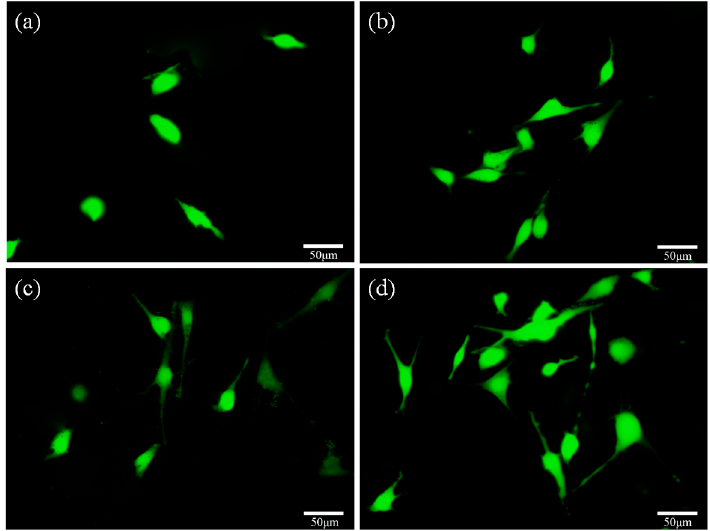
Figure 11. Fluorescence microscopies of MG63 cells cultured on scaffolds without CaSiO 3 ( a , b ) and scaffolds with 20 wt % CaSiO 3 ( c , d ) for three days ( a , c ) and five days ( b , d ).